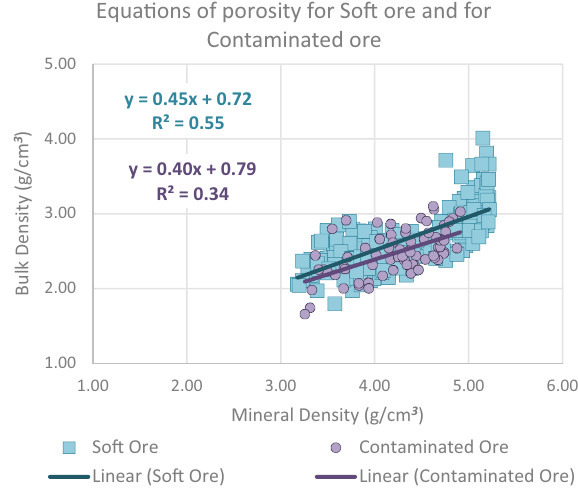
Fig. 9 Plot of mineral density versus bulk density for weathered samples. Regression equations are used to obtain the angular coef- ficient, which represents the porosity of soft and contaminated